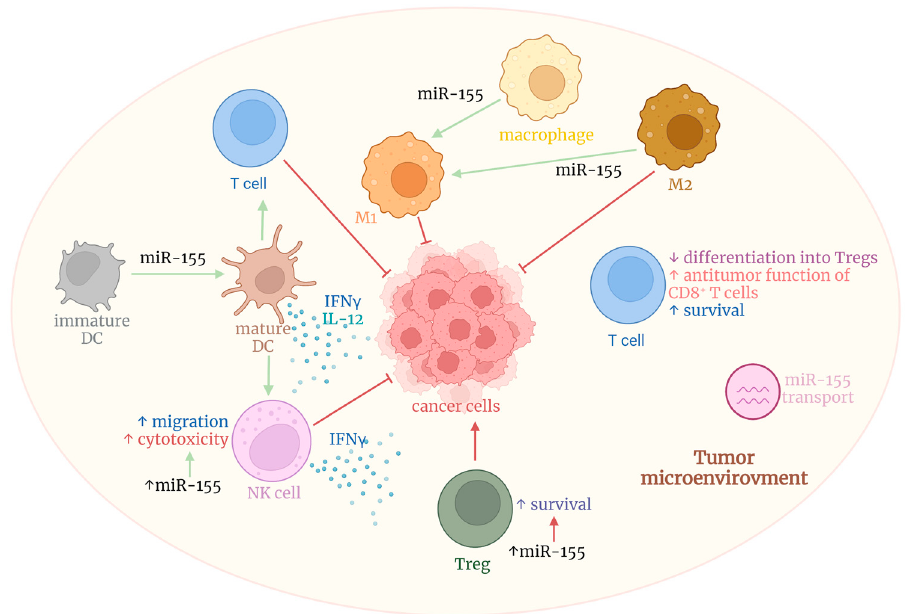
Figure 2. MiR-155-mediated shaping of the immune antitumor response. Created with BioRender.com (agreement number: RT24GT9RIE, accessed on 30 September 2022).